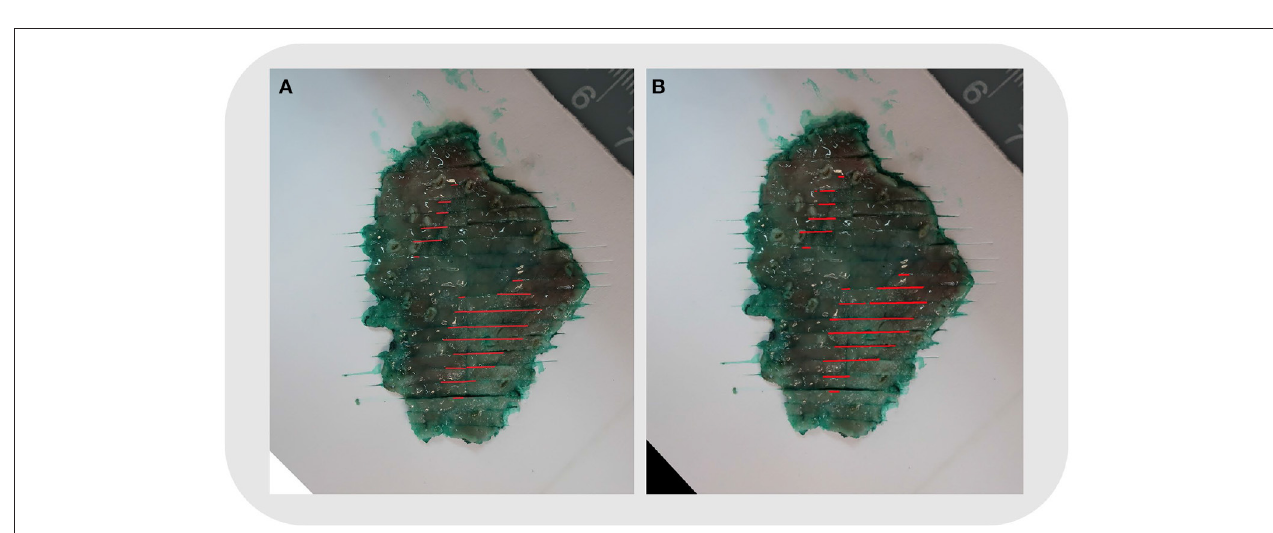
FIGURE 5 | Case No. 5: (A) Mapping using the traditional method. (B) Mapping by the system. The shape, size, and location of the tumor area were the same. The reconstructed map showed two foci of the tumor